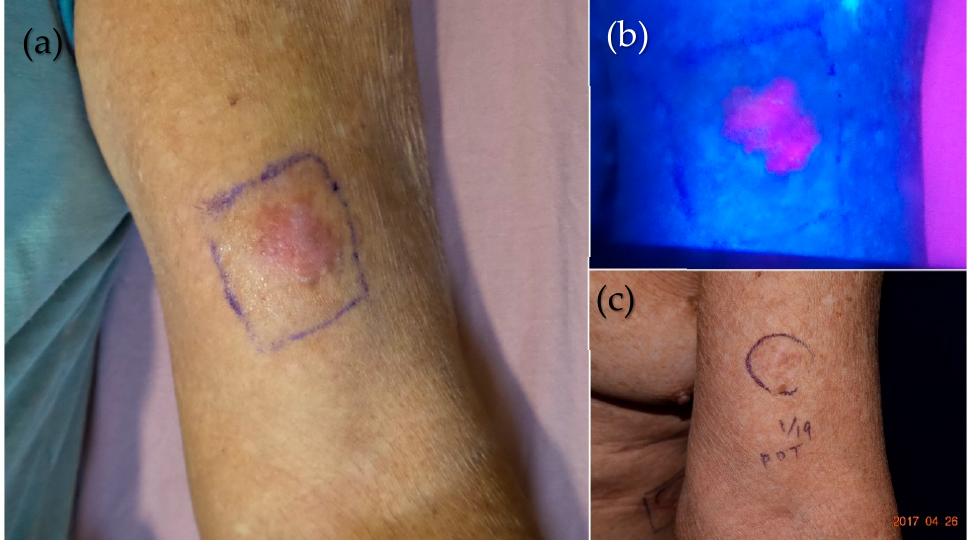
Figure 6. dPDT treatment on an elderly chronic arsenism patient with multiple Bowen’s diseases (BDs). ( a ) One BD on the left upper arm was marked to show the drug application area. ( b ) To improve the transdermal delivery of the photosensitizer, the lesion was occluded for one hour after being slightly curetted. A vivid pink fluorescence of PpIX was well localized within the tumor under Wood’s lamp examination. ( c ) The lesion was clinically clear after one treatment of 2 h of exposure to sunlight. No recurrence was noted one year after dPDT.